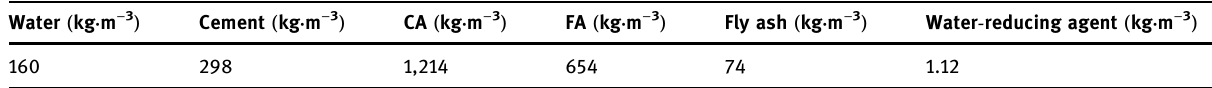
Table 5: Mixture proportions of concrete